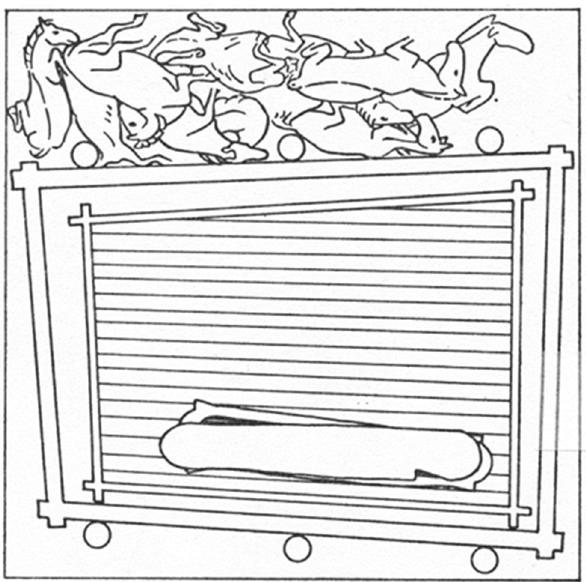
Figure 2. Plan of Kurgan 1 at Pazyryk (Adapted from Jettmar 1967: Figure 85). So, too, was the placement and manner of display of animals and their sculpted representational models. At both Pazyryk and Berel, the horses and their tack displayed indications of distant and different ownership. The suites of horse decoration in Berel 11 point to different geographical areas where allies of the deceased resided according to Francfort (Francfort et al. 2006, pp. 122–23; Francfort and Lepetz 2010). Although the distinctive genomic changes reported by Librado and the assembled team suggest that domestication of the horse in Eurasia occurred through the mixing of lineages (Librado et al. 2016; 2017), and that mix is consistently discerned in those animals tested throughout the Pazyryk Culture sites such as at Berel, the Keyser-Tracqui team did not discern geographic affiliations for the animals themselves (Keyser-Traqui et al. 2005, p. 203). 3 Such distinctions may have been made in the manner in which the animals were presented. For example, at Pazyryk, the ears of horses were clipped with distinctive marks, which have been thought to represent different owners (Rudenko 1970, pp. 117–19). In contrast to the suggestions about horses being gifted at the time of death from multiple sources, as at Berel 11, Rudenko suggested that all horses buried with the deceased were the deceased’s own (1970, p. 119). Furthermore, Gala Argent, through an analysis of the masks and other tack on the Pazyryk horses, does concur that the horses belonged to the deceased and that the ornamentation communicated the role(s) each horse played in the life of the person in